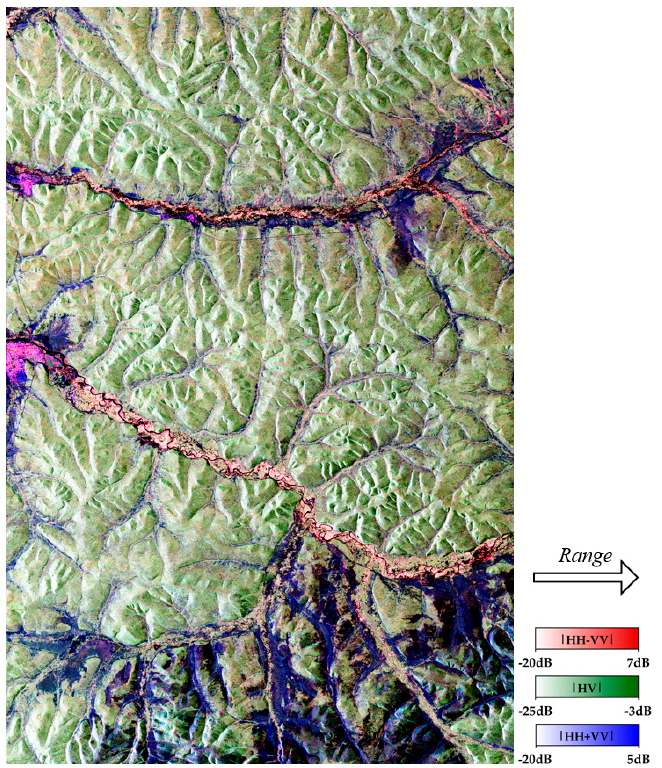
Figure 6. Pauli RGB of PolSAR data.